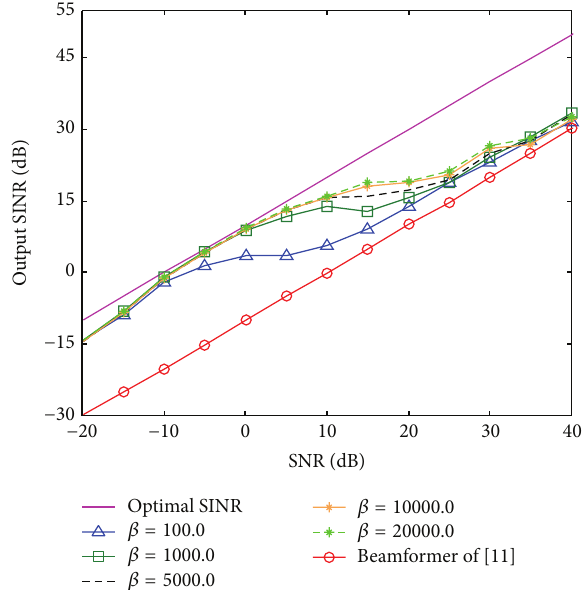
Figure 18: Output SINR versus the input SNR with different 𝛽 (INR =